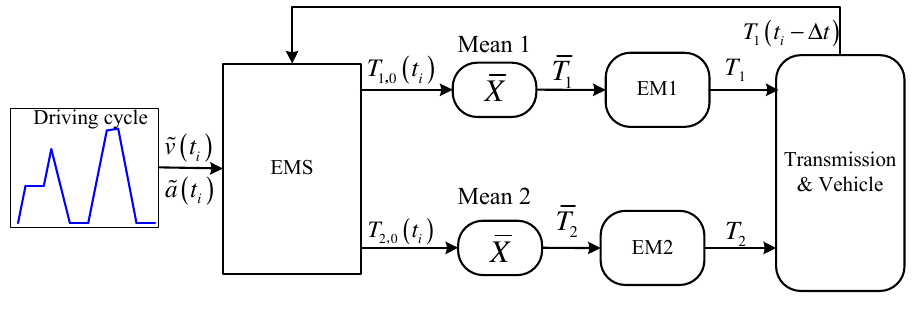
Figure 5. Control scheme of BDCS.